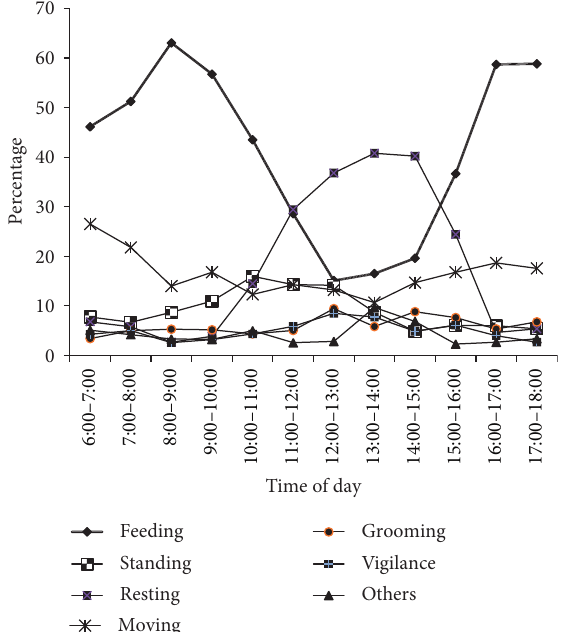
Figure 4: Timely activity budget of klipspringers during dry and wet seasons in the study